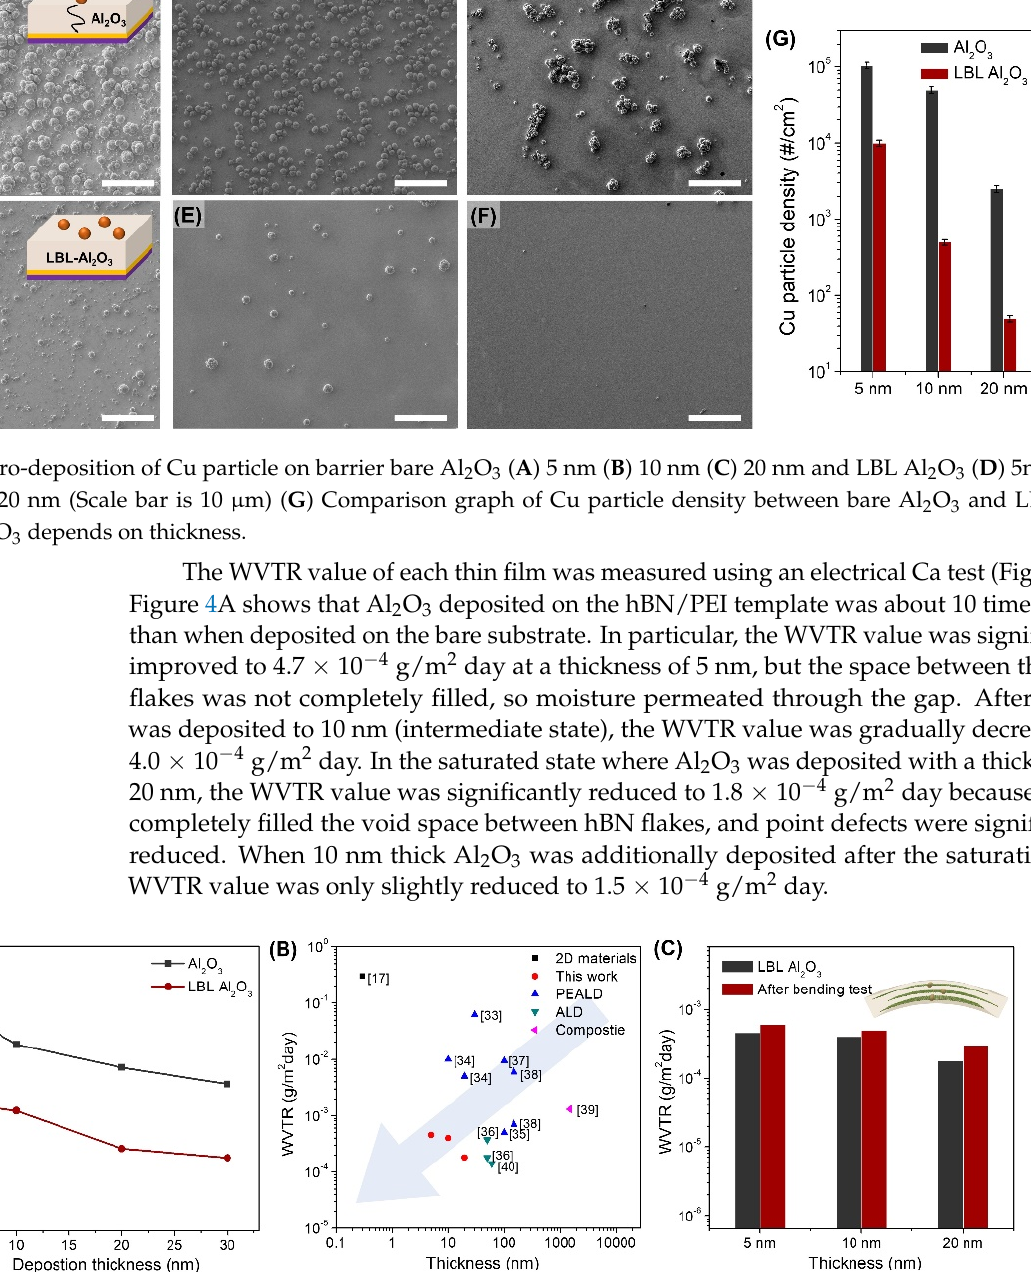
Figure 4. ( A ) WVTR comparison plot of Al 2 O 3 layers deposited on the bare PEN substrate and hBN/PEI/PEN substrate depending on the thickness ( B ) A plot of WVTR vs. thickness of the PEI/hBN barrier compared to previously reported values ( C ) WVTR values of LBL deposited Al 2 O 3 layer before and after bending fatigue test (Bending radius: 3 mm (Tensile strain: 4%), 5000 cycles).